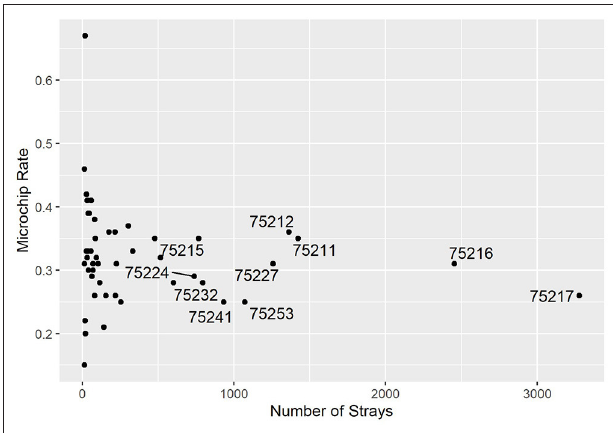
FIGURE 7 | Microchip rate vs. number of strays by ZIP code. Highest-intake areas are labeled.